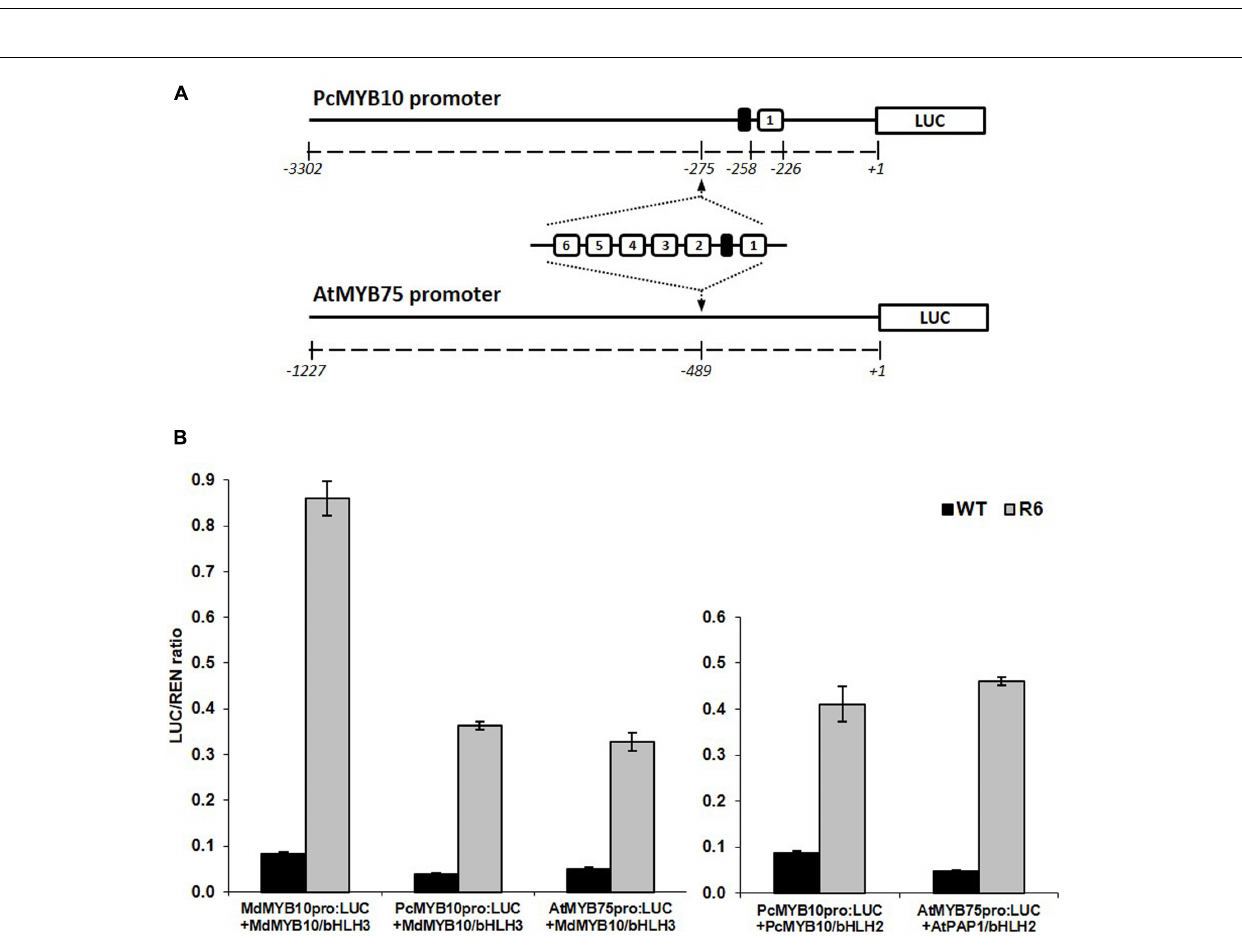
FIGURE 4 | Insertion of the R6 domain in the promoter of MYB10 orthologs leads to autoregulation. (A) Schematic of the engineered pear MYB10 and AtMYB75 promoters fused to the LUC reporter gene in pGreen0800LUC. (B) Dual luciferase promoter assay of the R6 engineered promoters in N. benthamiana . Promoters, with or without the R6 domain, were co-infiltrated with MdMYB10 and MdbHLH3, PcMYB10 and AtbHLH2, or AtMYB75 and AtbHLH2. Luminescence of LUC and REN was measured 3 days post-infiltration and expressed as a ratio of LUC to REN. Data represent means ( ± SE) of four technical replicate reactions.